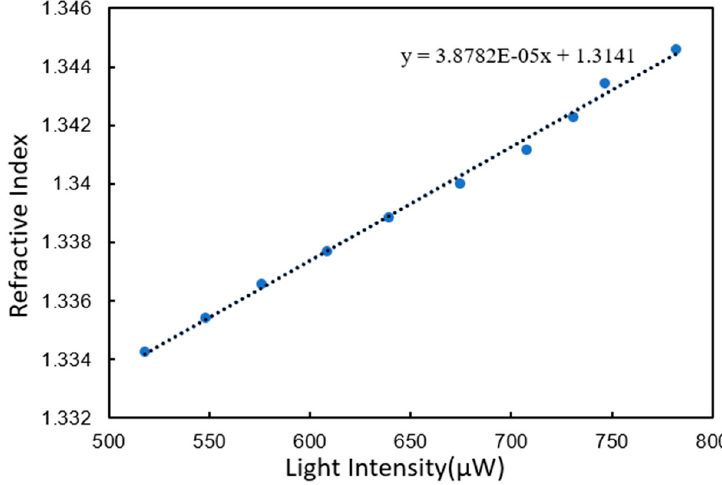
Figure 5. Linear regression curves of unmodified gold film chip.